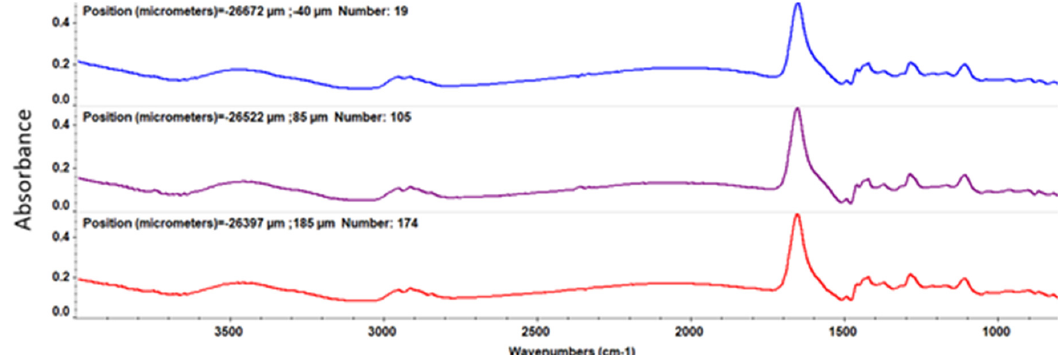
Figure 7. IR spectra of PVP/ZnO@LiN coatings at 200 mJ/cm 2 laser fluence.